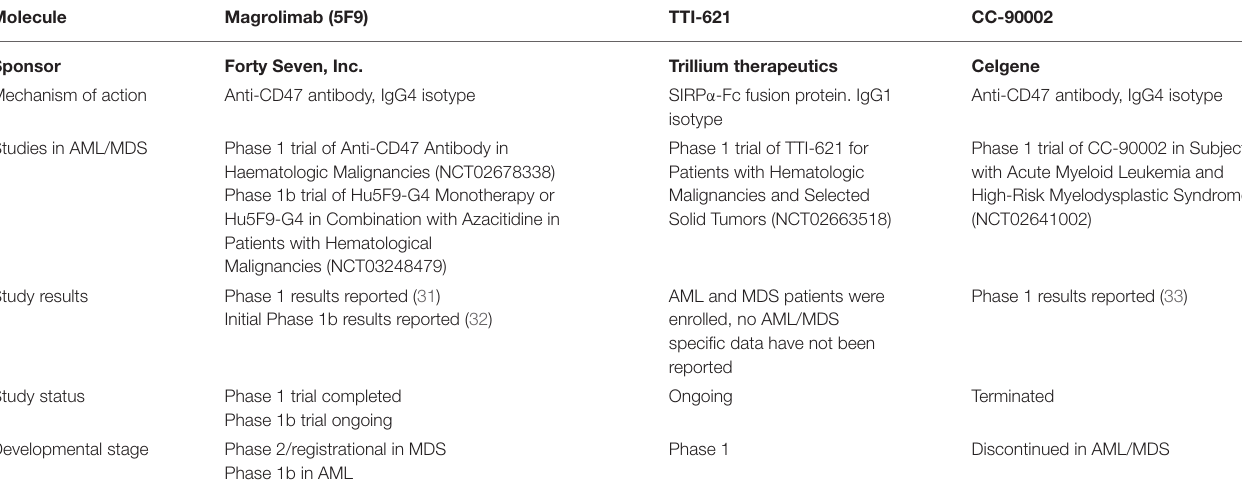
TABLE 2 | CD47/SIRP α targeting agents investigated in AML and/or